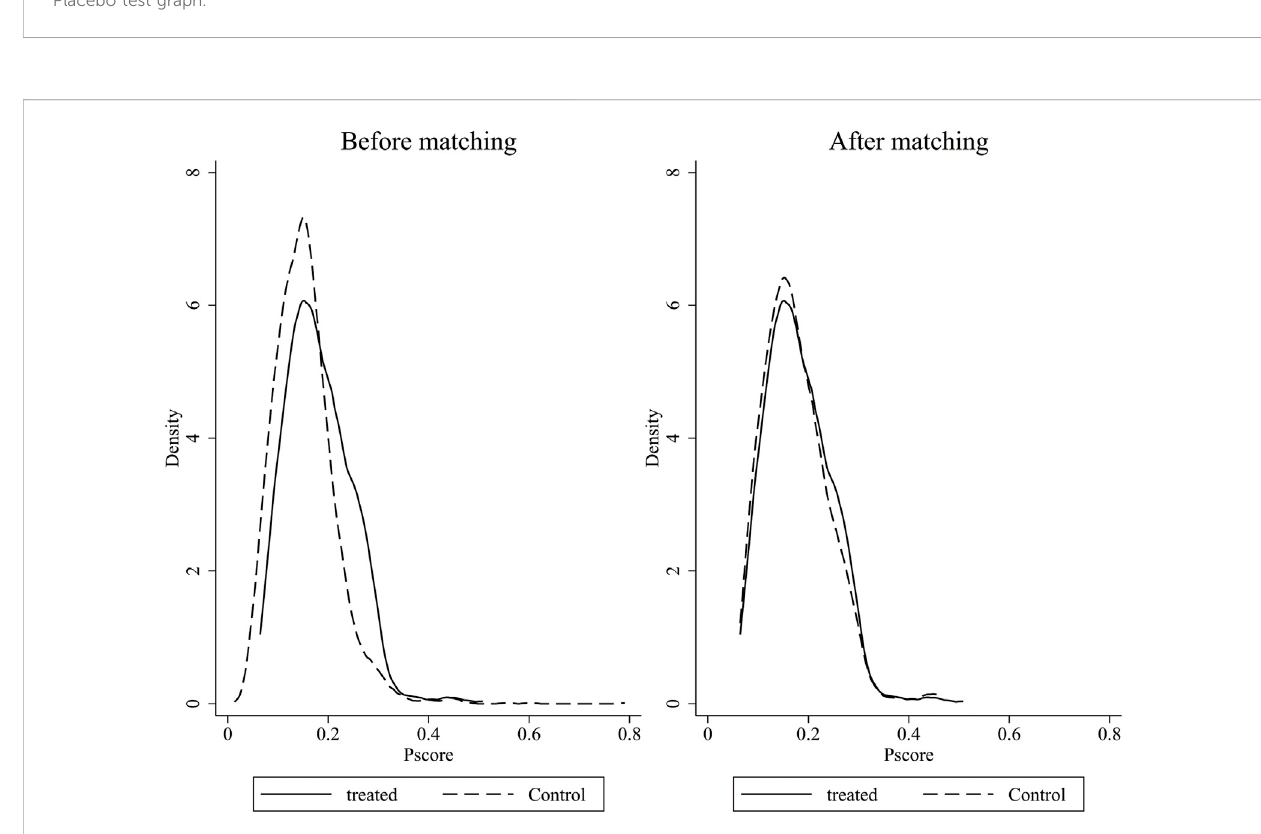
FIGURE 3 Density distribution graph of